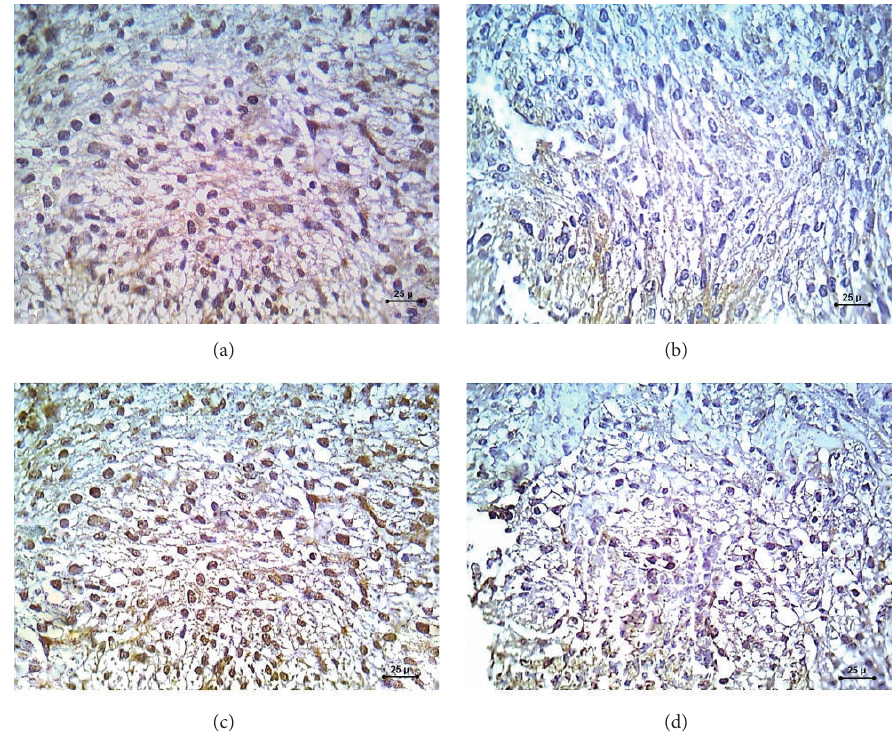
Figure 3: A photomicrograph of KI67 immunohistochemical staining ( × 400) sections in the fetal myocardium. (a) Control group showing dense positive brown nuclear immunohistochemical staining with KI67. (b) STZ-induced DM group showing negative nuclear immunohisto- chemical staining with KI67. (c) STZ-induced DM treated with zinc group showing moderate positive nuclear immunohistochemical staining with KI67. (d) STZ-induced DM treated with insulin group showing minimal positive nuclear immunohistochemical staining with KI67.